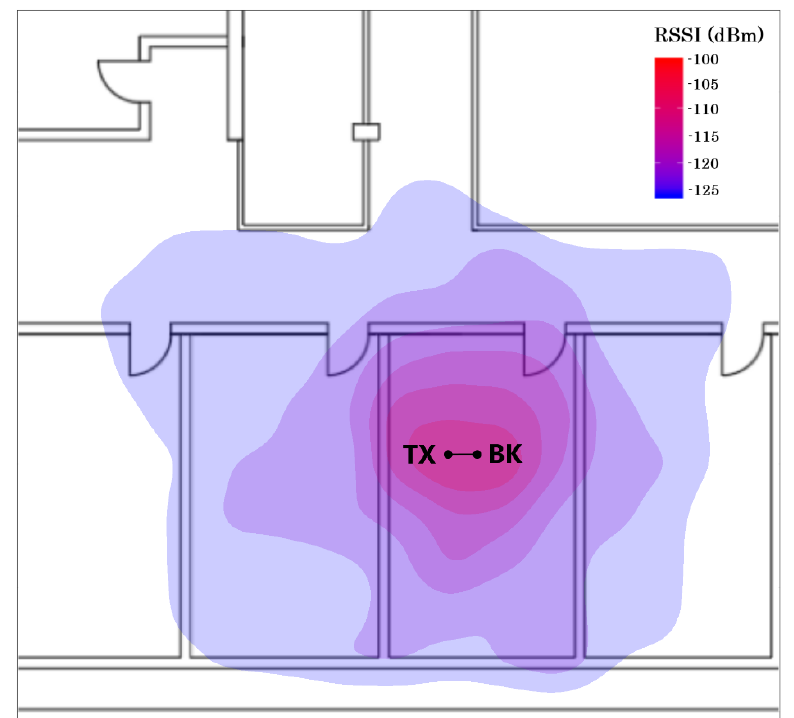
Figure 22. Measured RSSI heat map for the transmitter located 0.8 m from the vessel with the backscatter immersed (the points marked as BK and TX indicate the location of the backscatter and the transmitter, respectively).